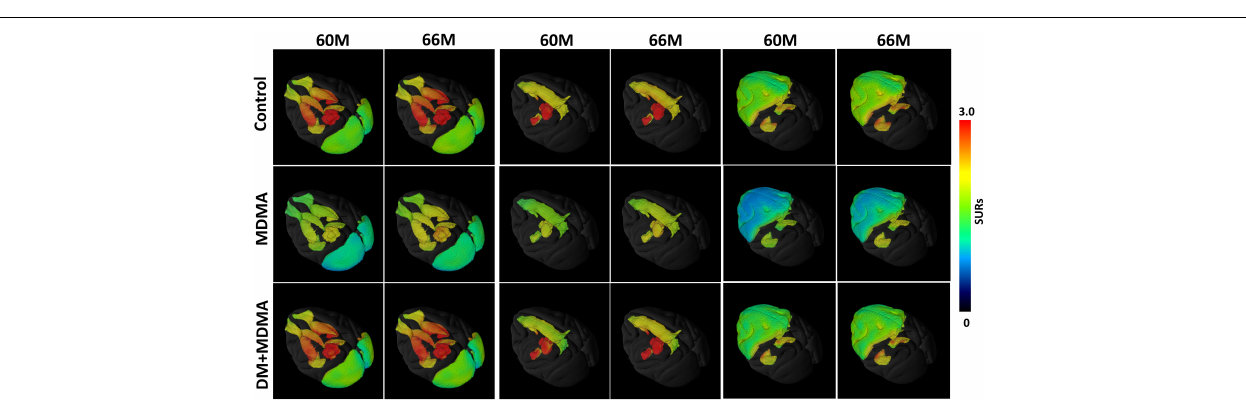
FIGURE 3 | 3D PET parametric SUR imaging obtained 120–150 min after intravenous injection of [ 18 F]-4-ADAM in different regions. Multiple-assembly brain region (top row); control group (second row); MDMA group (third row); and DM + MDMA group (bottom row). PET images were co-registered to MRI-based atlas to generate 3D PET/MR images (PMOD version 4.0, PMOD Technologies, Zurich,